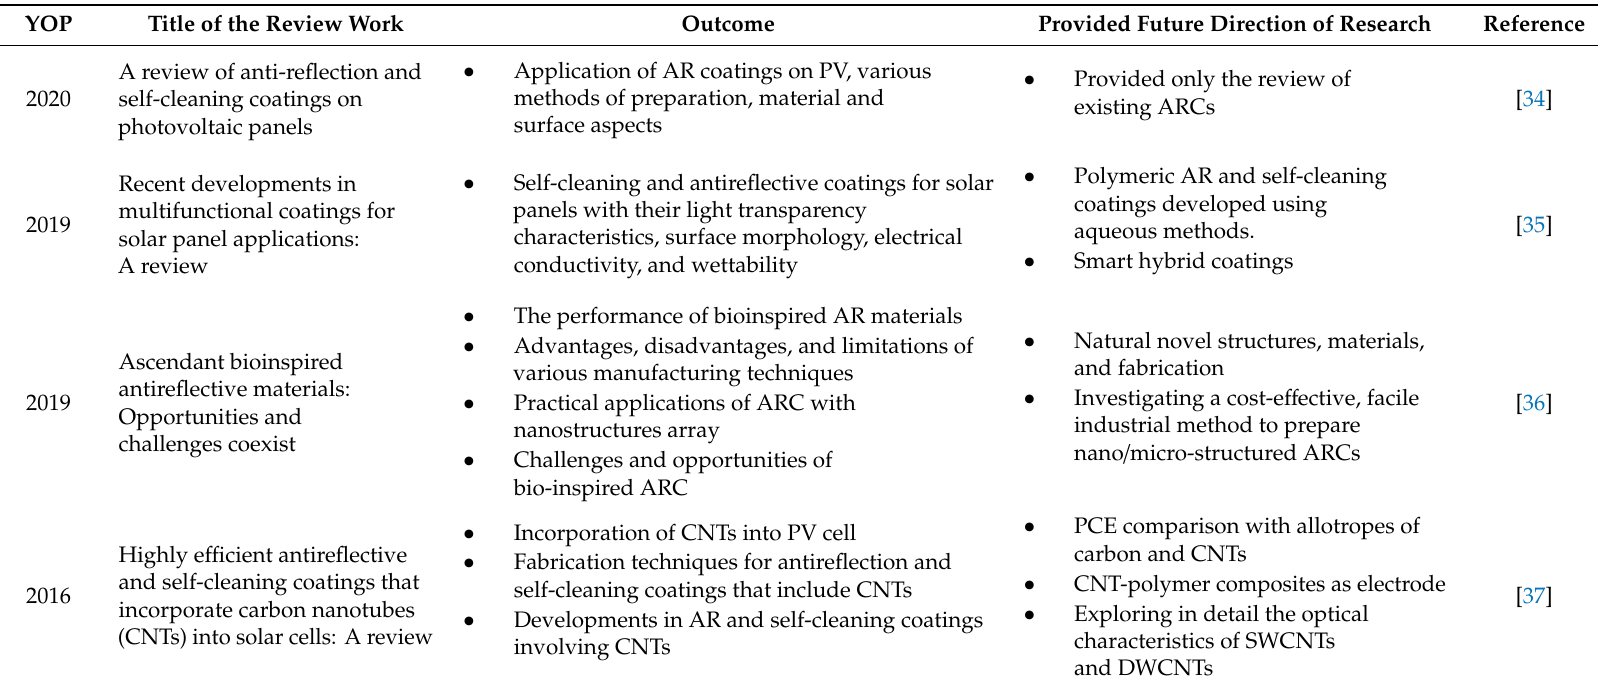
Table 1. Various review works on antireflection